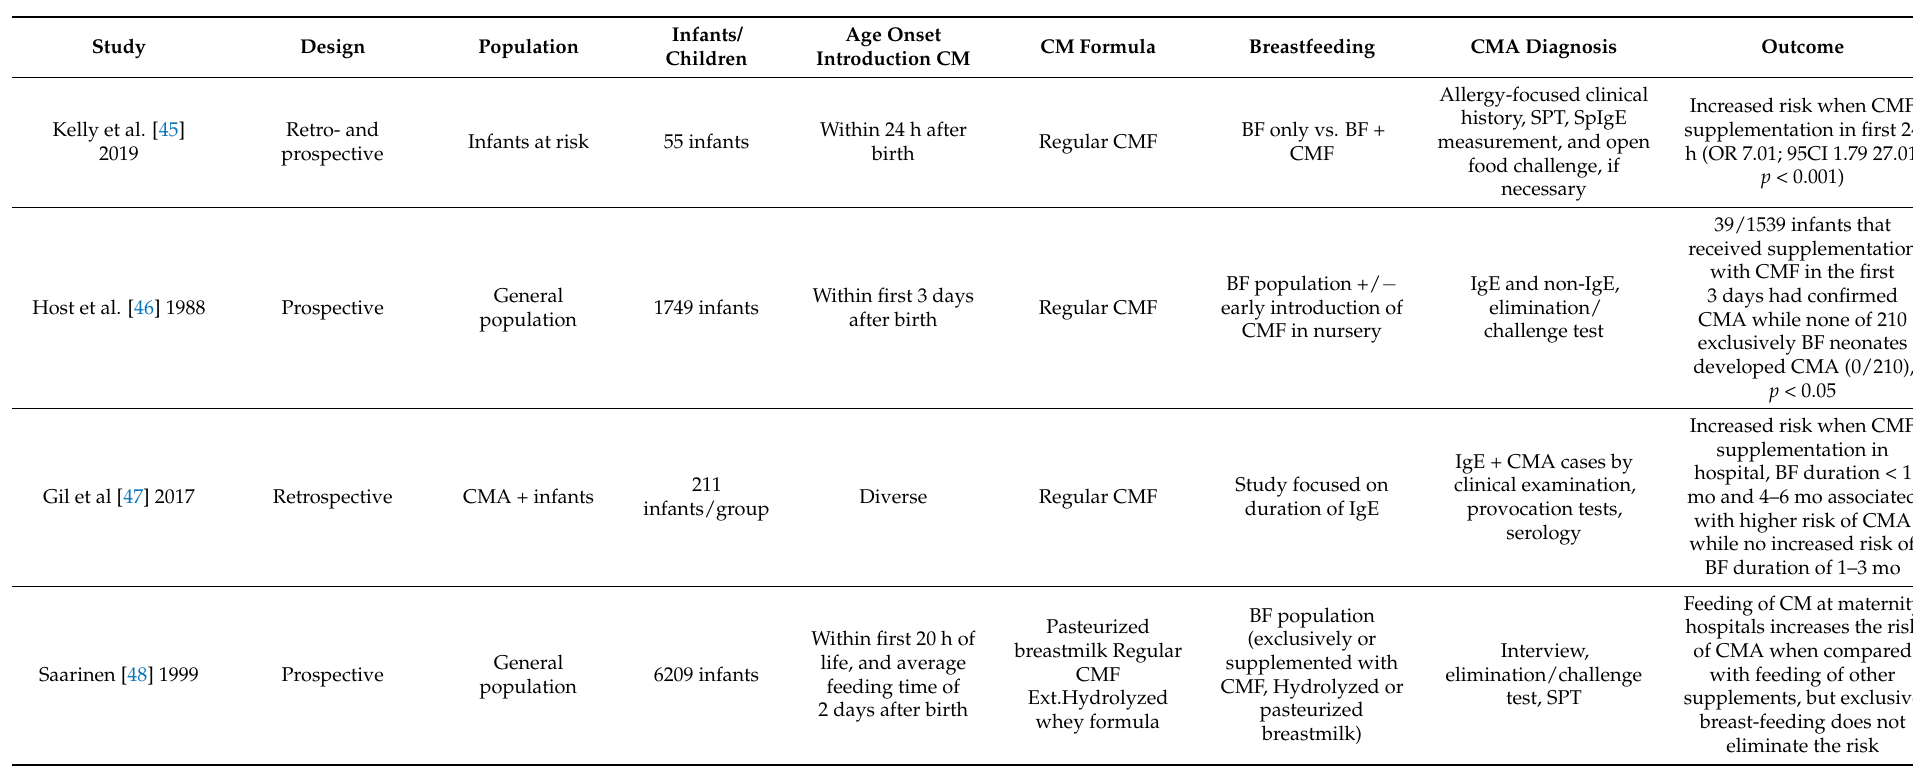
Table 1. Studies on very early introduction of cow’s milk in first days of life [45–49] and early introduction of cow’s milk